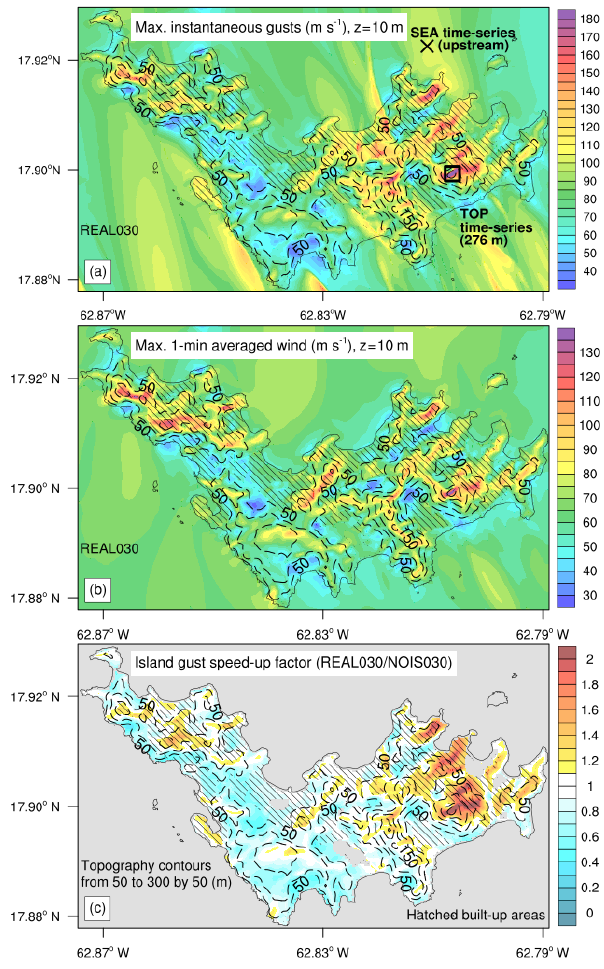
Figure 8. Saint Barthélemy 30m scale maximum surface winds during the 6h of simulation (history output interval of 1min). (a) Maximum instantaneous gust (ms − 1 ) with locations of two numerical time-series stations: SEA and TOP. (b) Maximum 1min averaged wind in ms − 1 . (c) Island gust speed-up factor (REAL030/NOIS030). Topography contours in meters and hatched built-up areas are plotted on the three